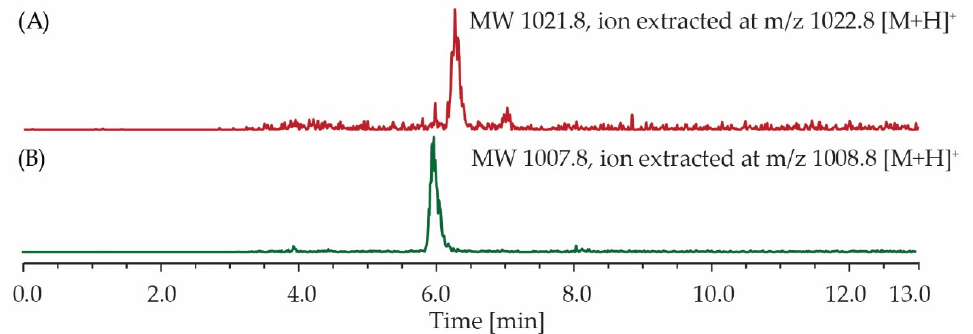
Figure 4. LC–MS ion extraction chromatograms of caecum extracts produced from a single animal sample fed with Bacillus composition F1. The spectra revealed the presence of ( A ) C14 surfactin C and ( B ) C13 surfactin C. MW—Molecular Weight.